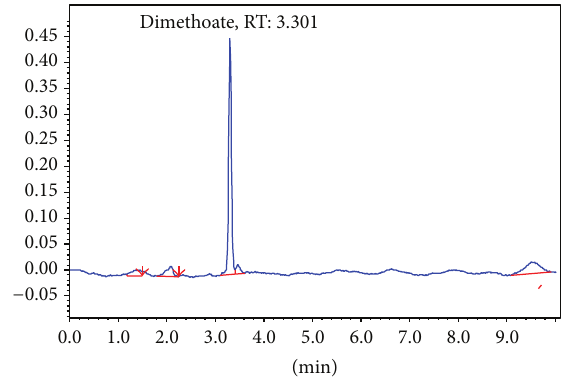
Figure 2: Chromatogram of VS-9 showing the presence of dimethoate (RT: 3.301